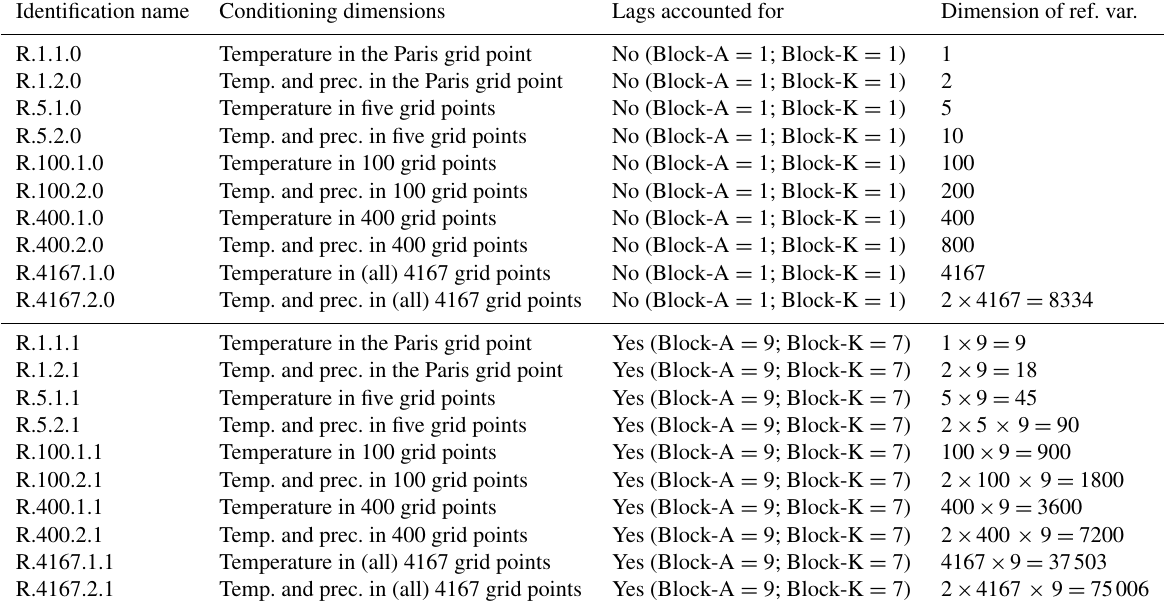
Table 1. Summary of the 20 R 2 D 2 configurations tested. The identification name is organized in the following way. The first number indicates the number of grid points used for the conditioning dimension of R 2 D 2 ; the second one corresponds to the number of variables considered at each grid point for the conditioning dimension (here, “1” indicates “only temperature”; “2” indicates “temperature and precipitation”); and the third number indicates if some lagged (i.e., temporal) information is used by R 2 D 2 (“0” means “no lag used”; “1” means “lags used”). “Block-A” corresponds to the block size (i.e., lag length) used for the analogue search and “Block-K” to the block size that is kept from the selected analogues of size